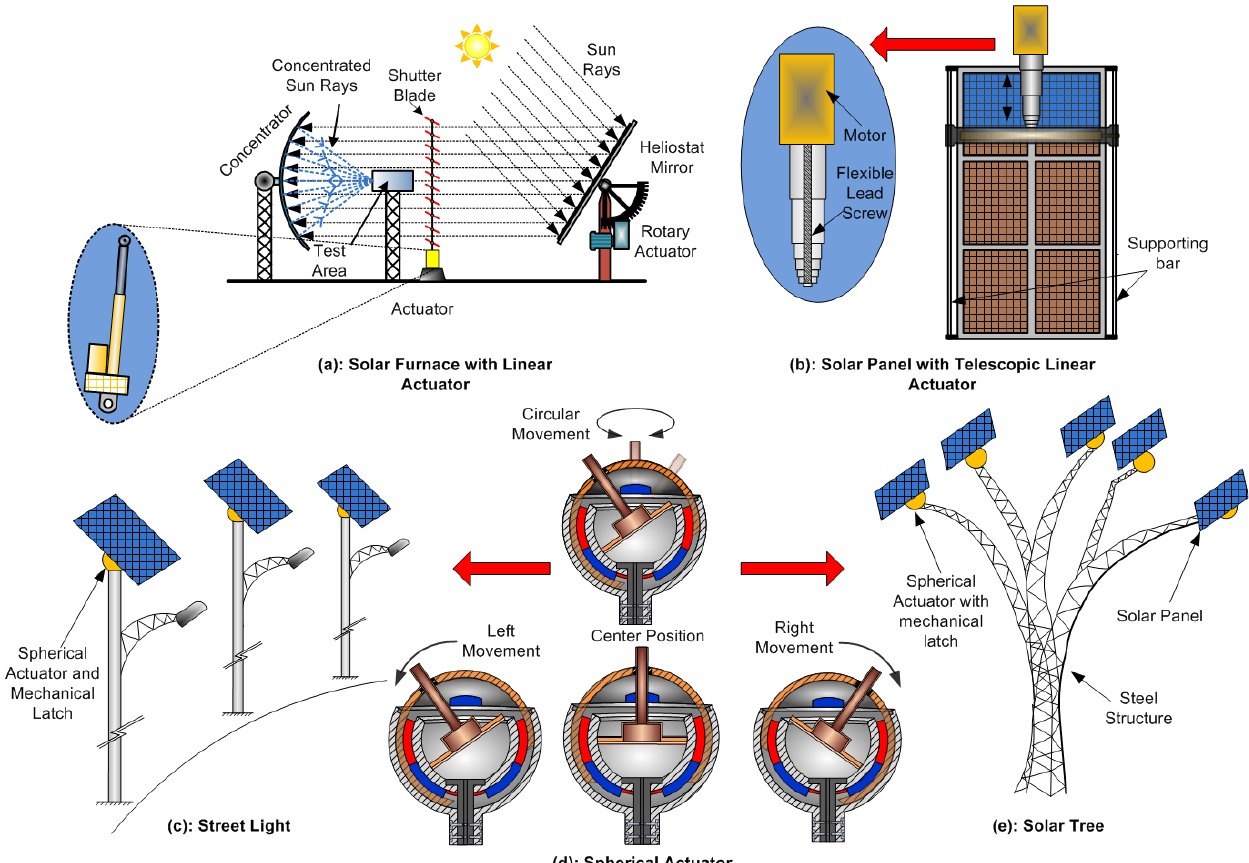
Figure 3. Proposed alternative actuators view: ( a ) solar furnace with linear actuator, ( b ) solar panel with telescopic linear actuator, ( c ) street light application with spherical actuator, ( d ) 2 DOF spherical actuator, ( e ) solar tree application with spherical actuator.